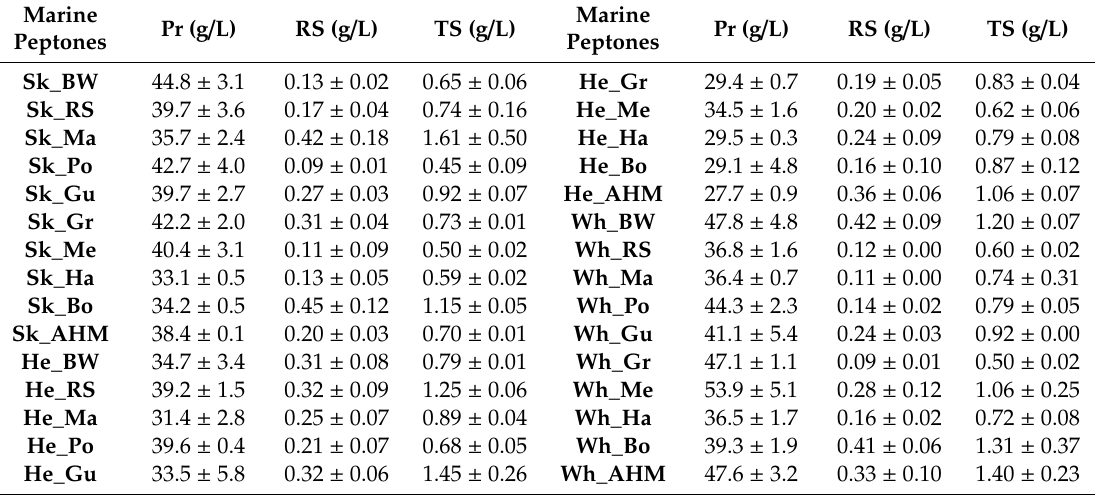
Table 1. Basic biochemical composition of marine peptones (mean values ± confidence intervals). Pr: total soluble protein; RS: reducing sugars; TS: total sugars. Sk, He, and Wh mean skin, head, and whole individual. BW: blue whiting, RS: red scorpionfish, Ma: mackerel; Po: pouting; Gu: gurnard; Gr: grenadier; Me: megrim; Ha: hake; Bo: boardfish, and AHM: Atlantic horse